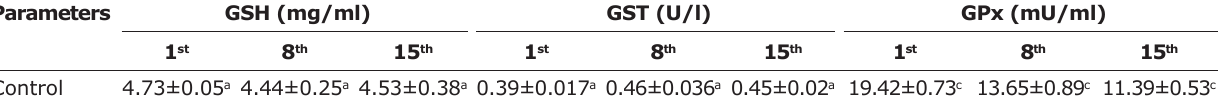
Table-3: Changes in GSH, GST, and GPx activities of C. gariepinus exposed to Roundup, Stomp, and both at 1 st , 8 th , and 15 th days of exposure (Mean±SE) (n=30).